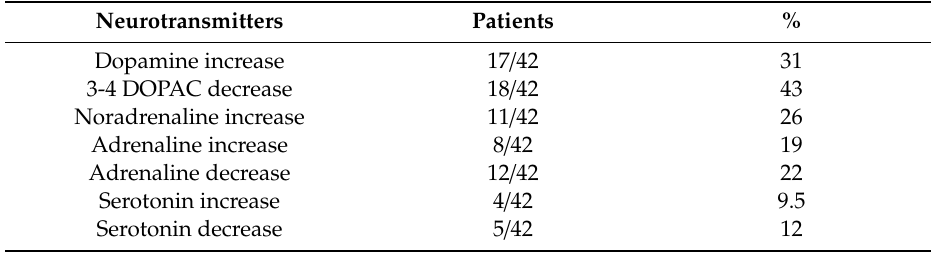
Table 6. Preliminary unpublished data based on the measurement of neurotransmitters and their